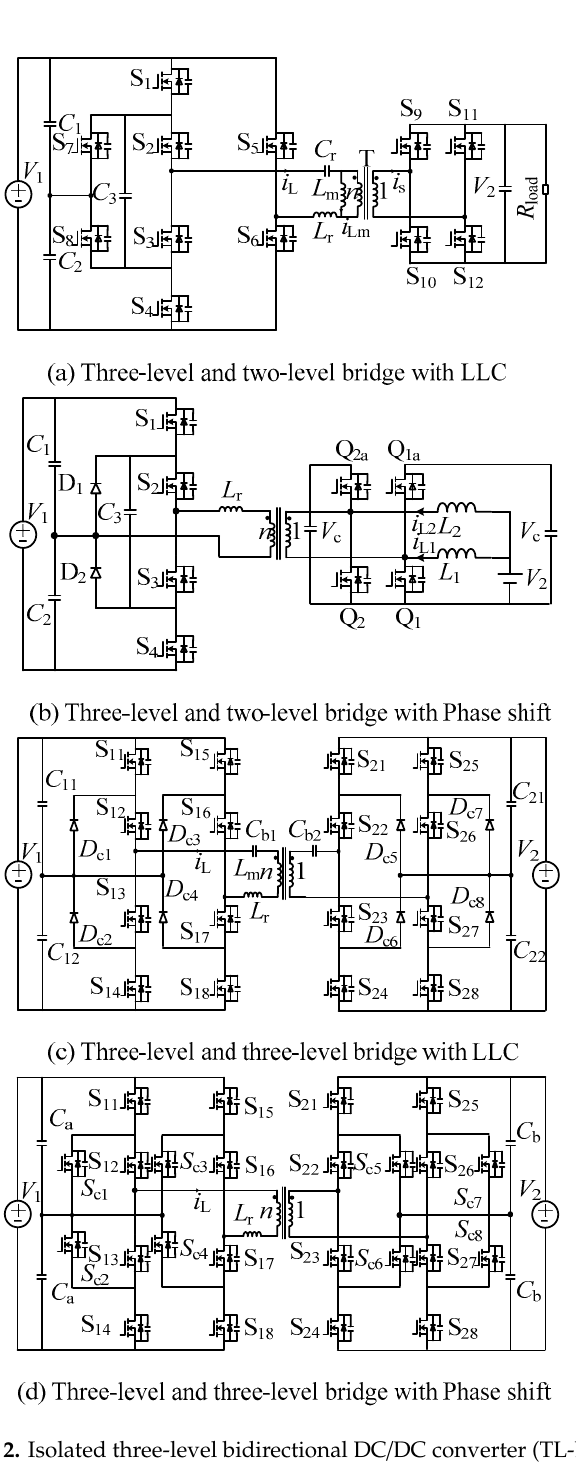
Figure 2. Isolated three-level bidirectional DC/DC converter (TL-BDC).